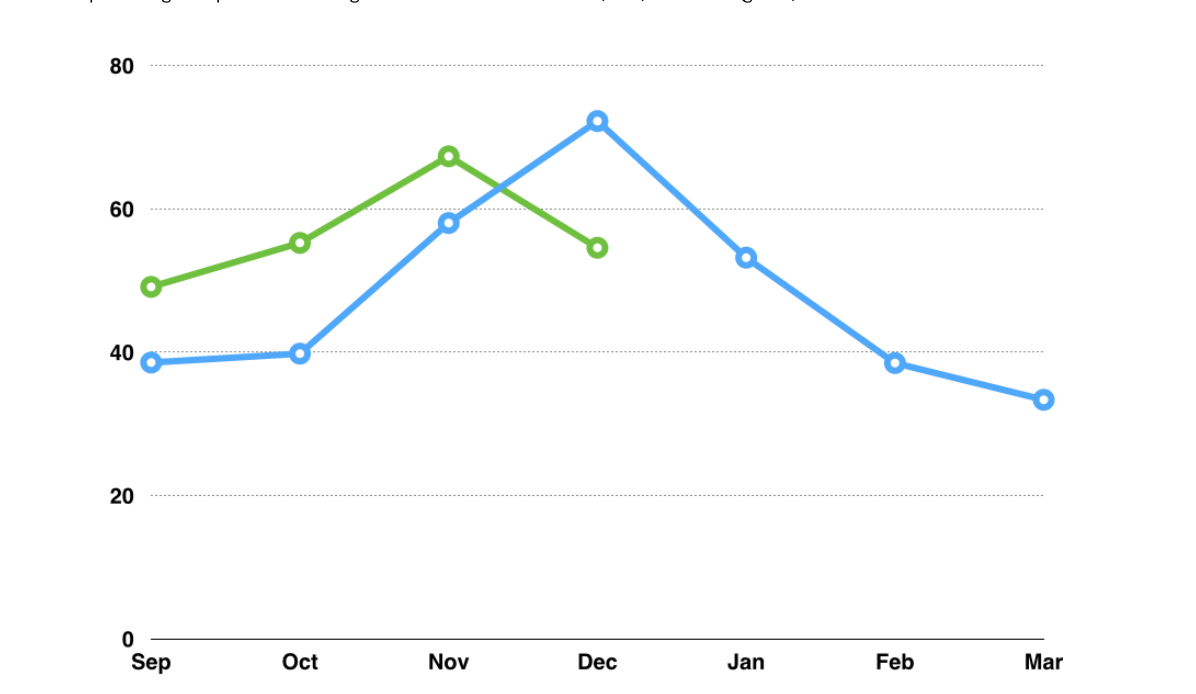
Figure 4. The percentage of questions relating to infections in 2011-2012 (blue) and 2012